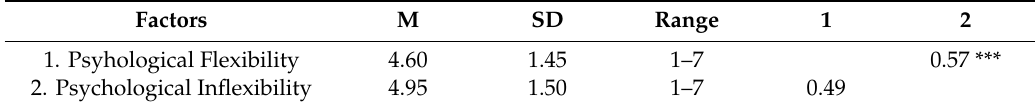
Table 1. Average, typical deviation, bivariate correlations and HTMT ratio of factors.